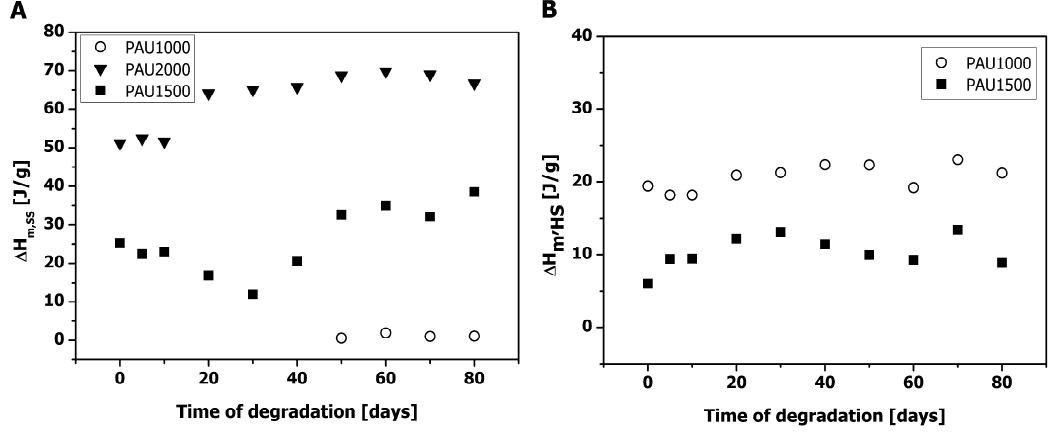
Figure 5. Soft segment and hard segment melt enthalpies of PAUs upon